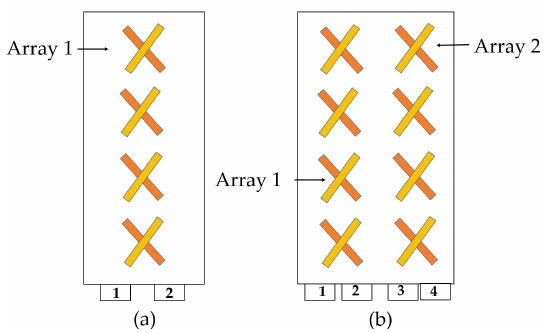
Figure 8. ( a ) Two-port single band antenna. ( b ) Four-port single band antenna. Inter-band isolation denotes the coupling between the arrays of different bands. In Figure 9, a dual-band antenna example is given, in which ports 1 and 2 represent feeds for Band 1, and ports 3 and 4 represent feeds for Band 2. The |S13|, |S14|, |S23|, and |S24| represent the inter-band isolation between ports of high and low band elements. In multi- band antennas, the isolation is measured in all frequency bands of operations, and typi- cally these levels need to be above 30 dB or higher.